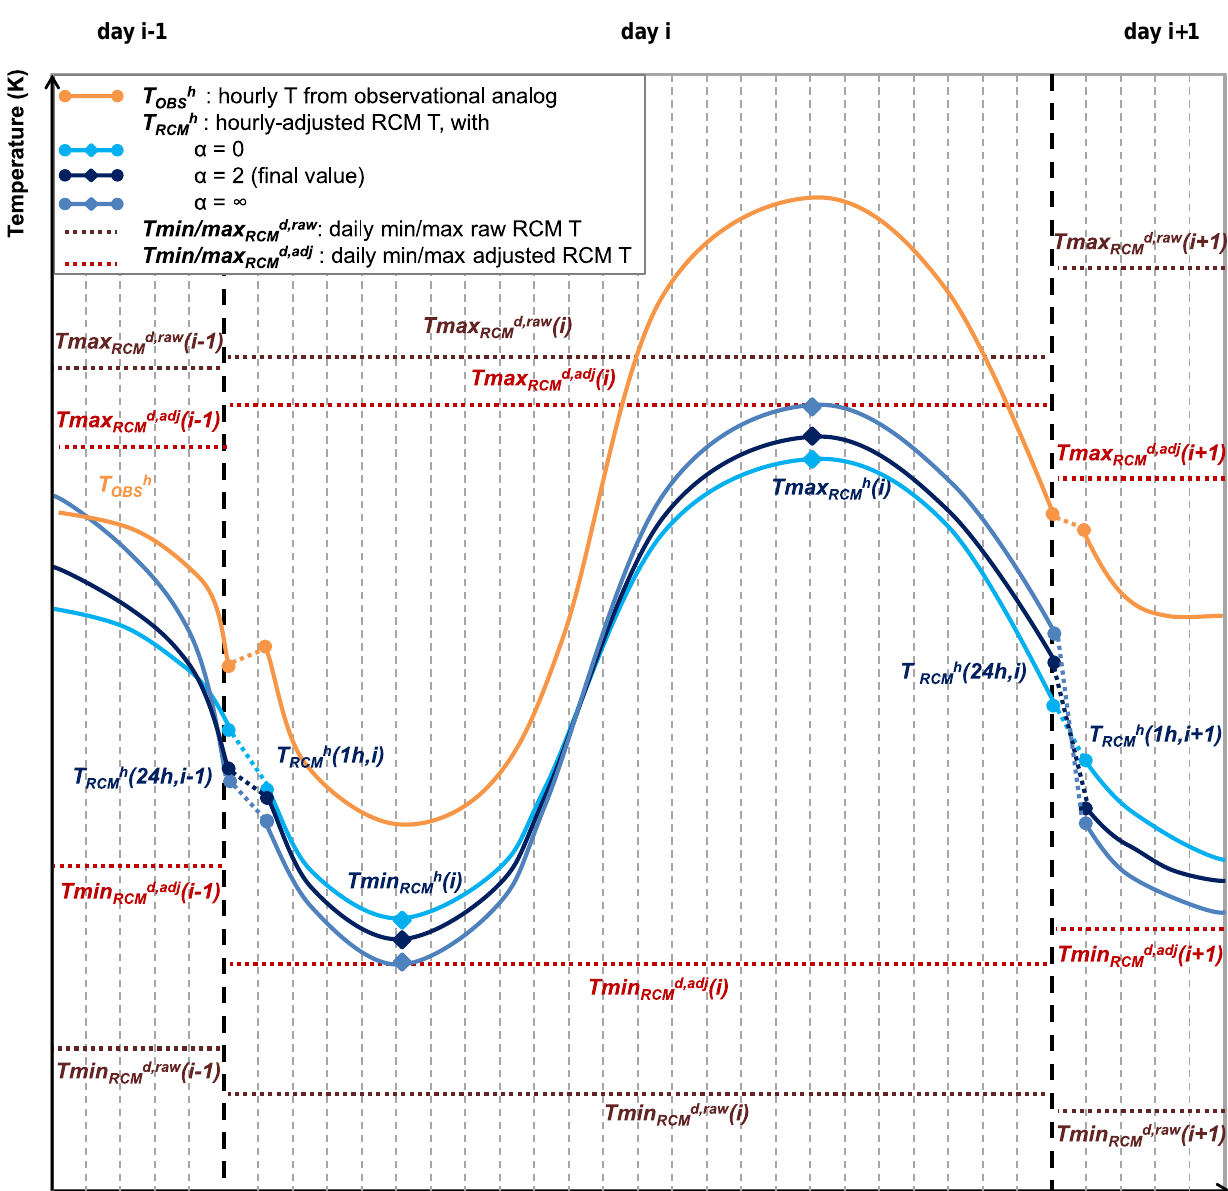
Figure 2. Timeline of the different parameters taken into account in the disaggregation of RCM temperature from a daily integration period ( 24h ,i − 1 ) are the hourly-adjusted RCM temperature values at the first time step of ( 1h ,i) and T h into an hourly time step. T h RCM RCM (i) and T max h (i) are the hourly minimum and maximum adjusted day i and at the last time step of the day before ( i − 1), T min h RCM RCM (i) and T max d, adj (i) are the daily minimum and maximum adjusted RCM temperature RCM temperature values, respectively, and T min d, adj RCM RCM values, respectively. α is a parameter which can be tuned to give more importance to the minimisation of differences between daily and hourly RCM minima and maxima. Hourly-adjusted RCM temperature time series for values of 0, 2 and infinity for α are shown. T h corresponds OBS (i) and T max d, raw (i) are the daily raw minimum and maximum RCM to the hourly series of the chosen daily analogue, and T min d, raw RCM RCM temperature values (before